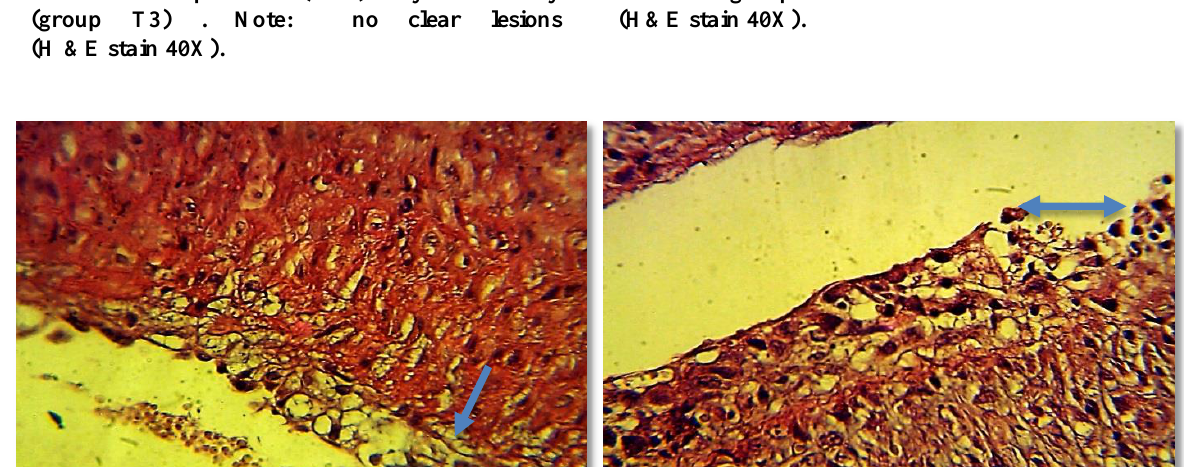
Figure,12: Section in the aorta of rabbit at after 42 of treatment with methionine over load (group T1).Note: increase thickness of intima, erosion and mononuclear cells infiltration in subintima (H &E stain